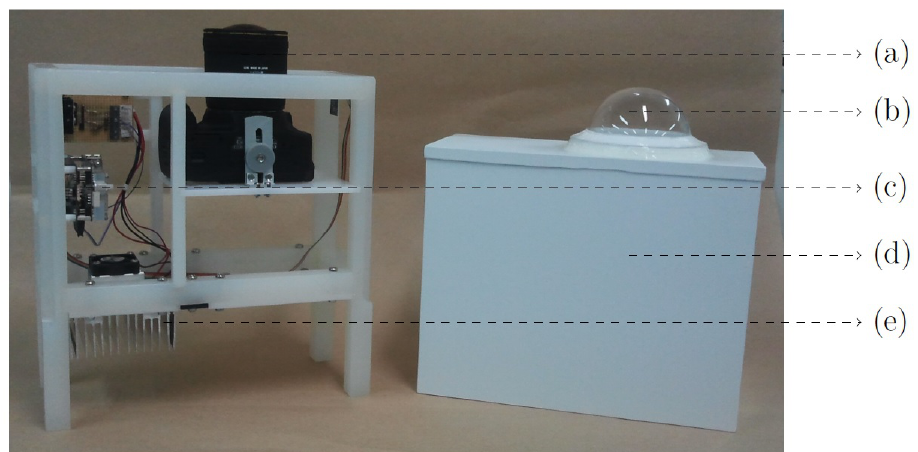
Figure 2. Photo of the WAHRSIS design: (a) DSLR camera, (b) dome, (c) ODROID board, (d) casing, (e) thermoelectric cooler with fans. Photo adapted from